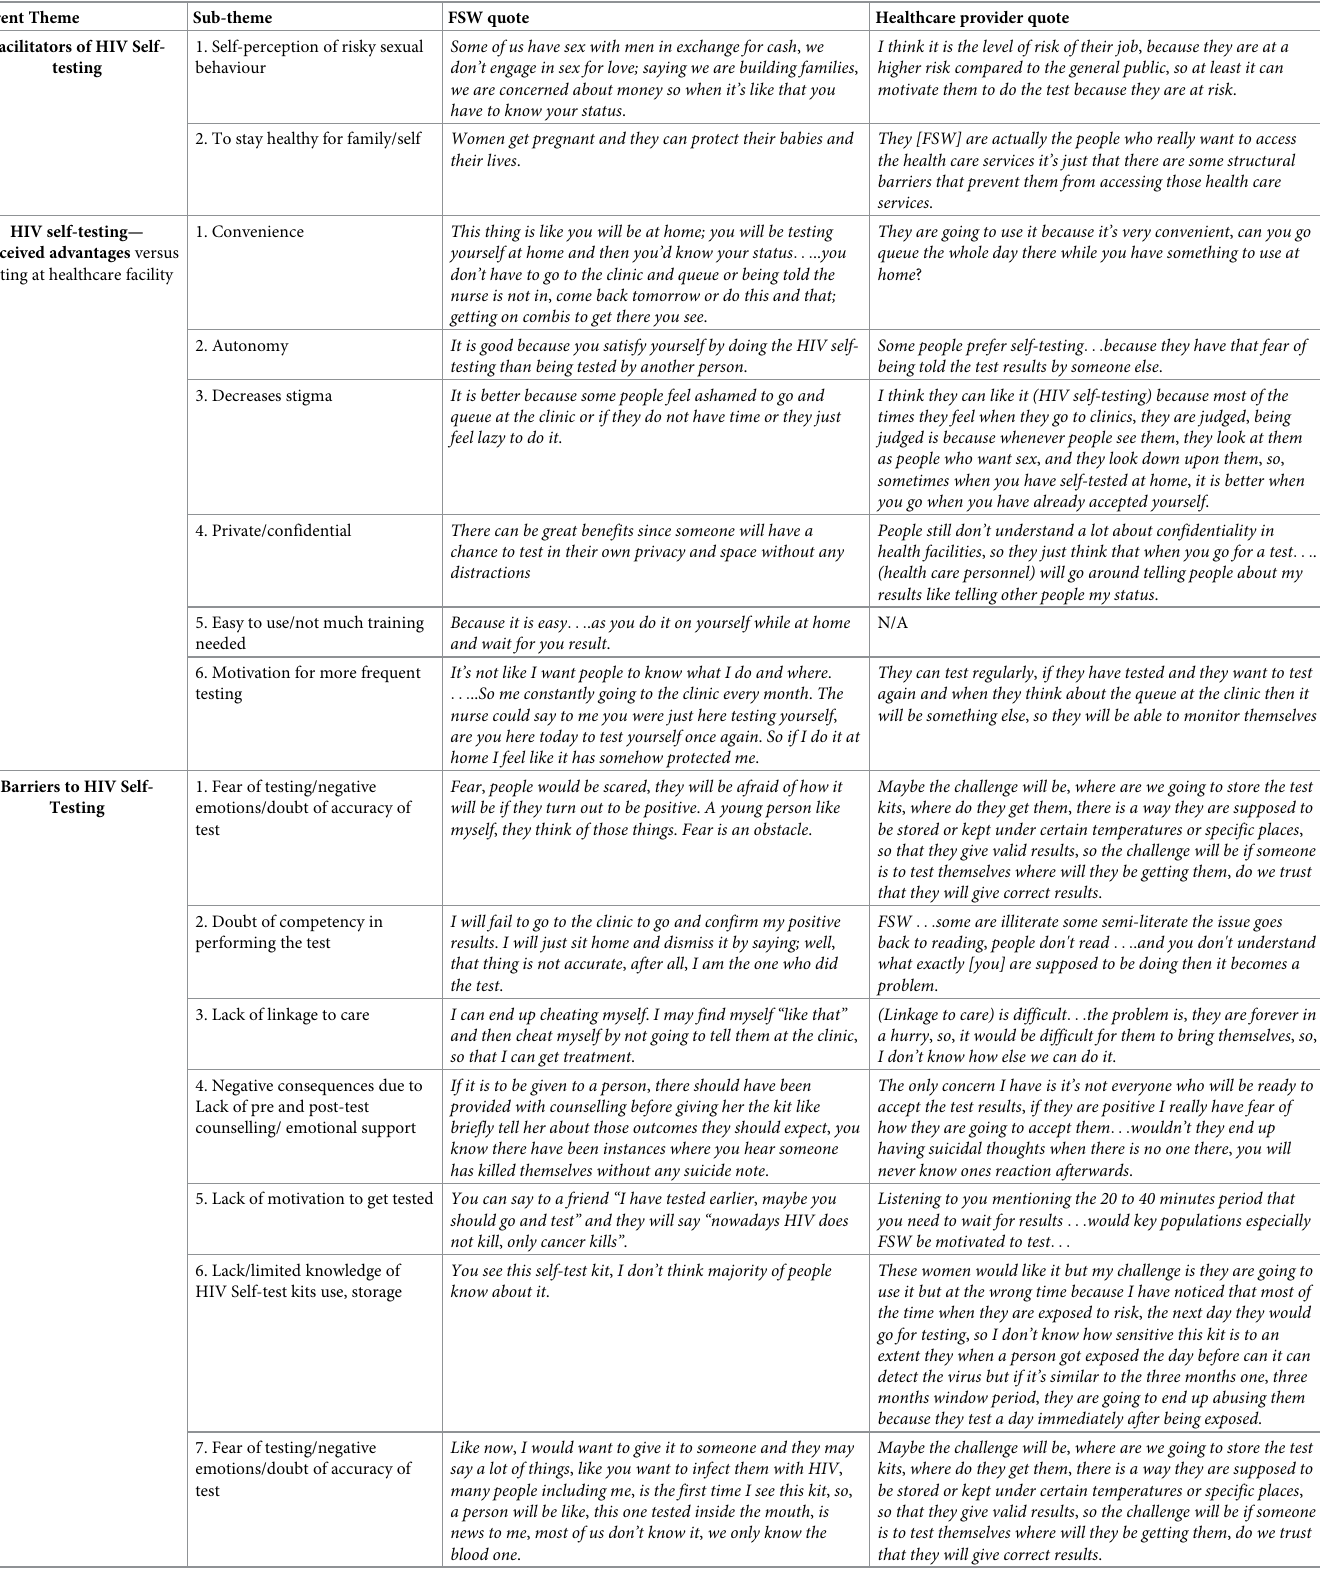
Table 1. Perceived barriers and facilitators regarding HIV self-testing among 30 FSW and 5 healthcare providers. Parent